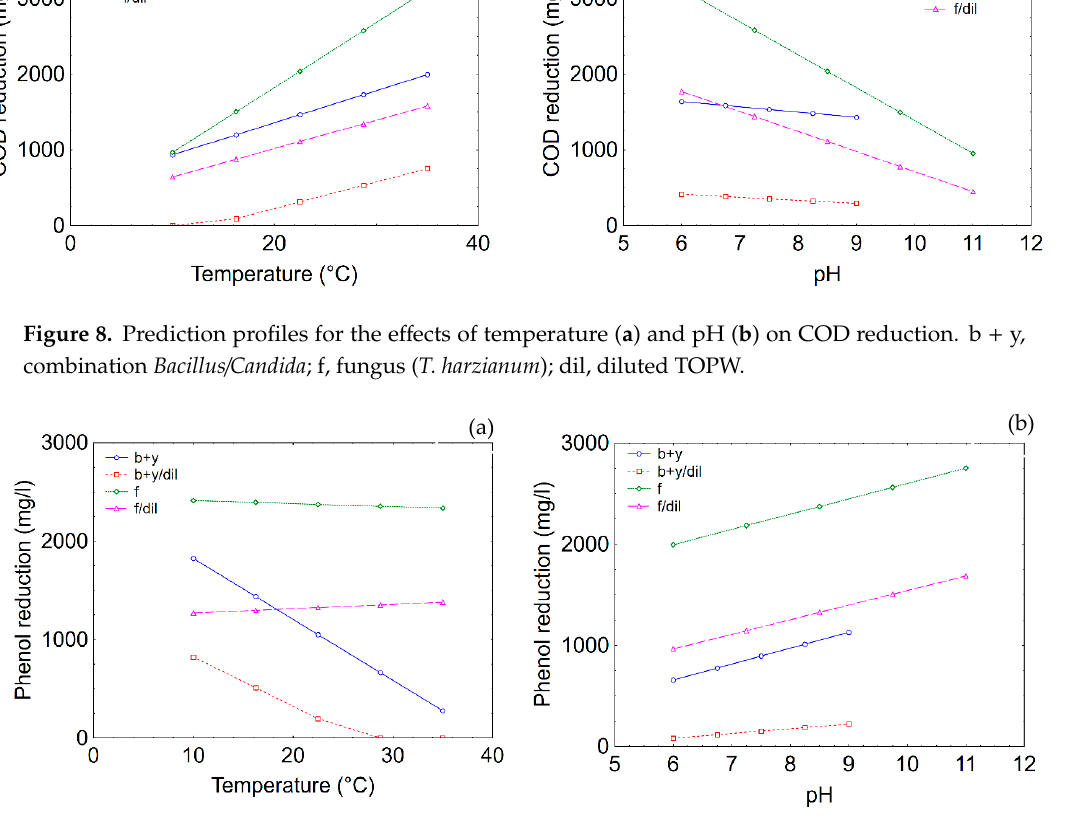
Figure 9. Prediction profiles for the effects of temperature ( a ) and pH ( b ) on phenol reduction. b + y, combination Bacillus/Candida ; f, fungus ( T. harzianum ); dil, diluted TOPW.